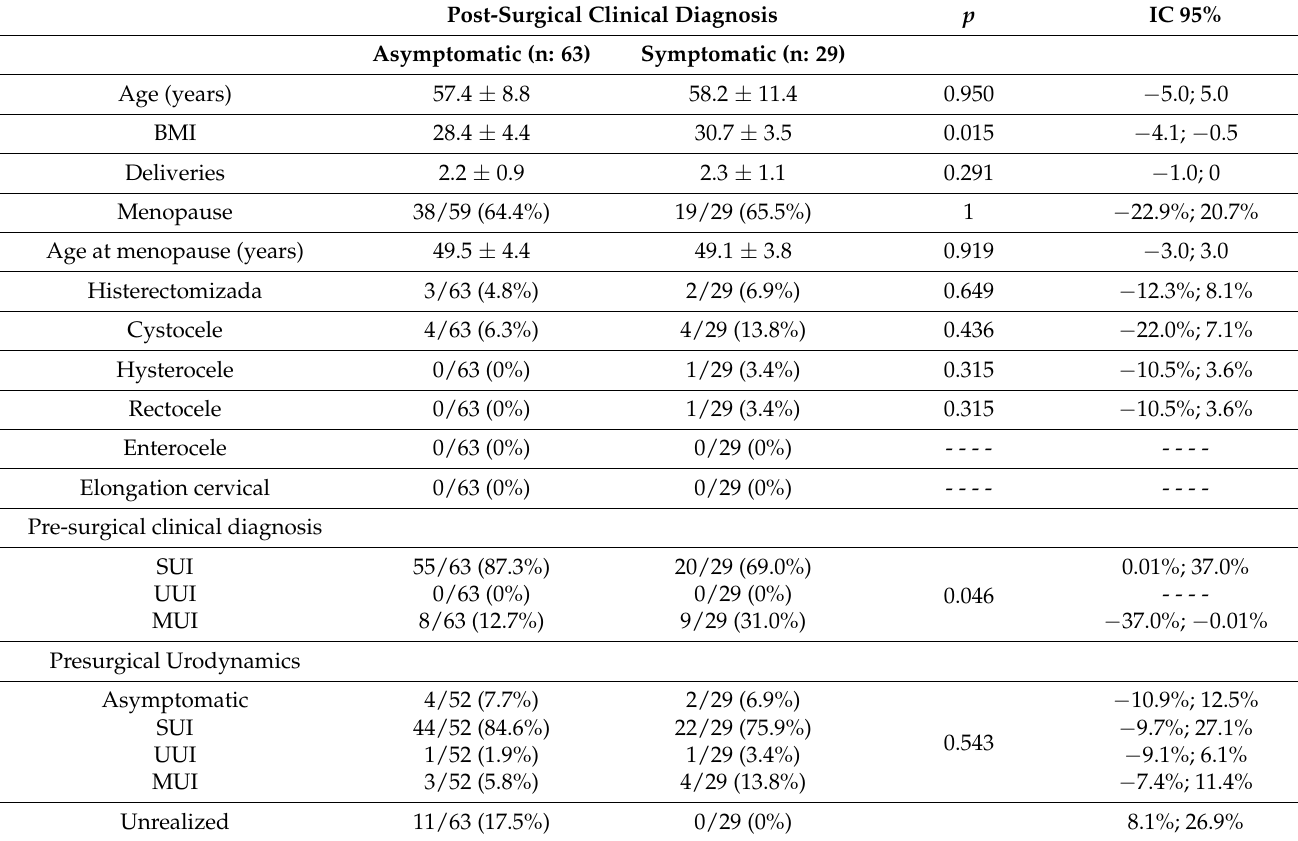
Table 1. General characteristics of the population studied, differentiating asymptomatic from symp- tomatic patients after placement of the